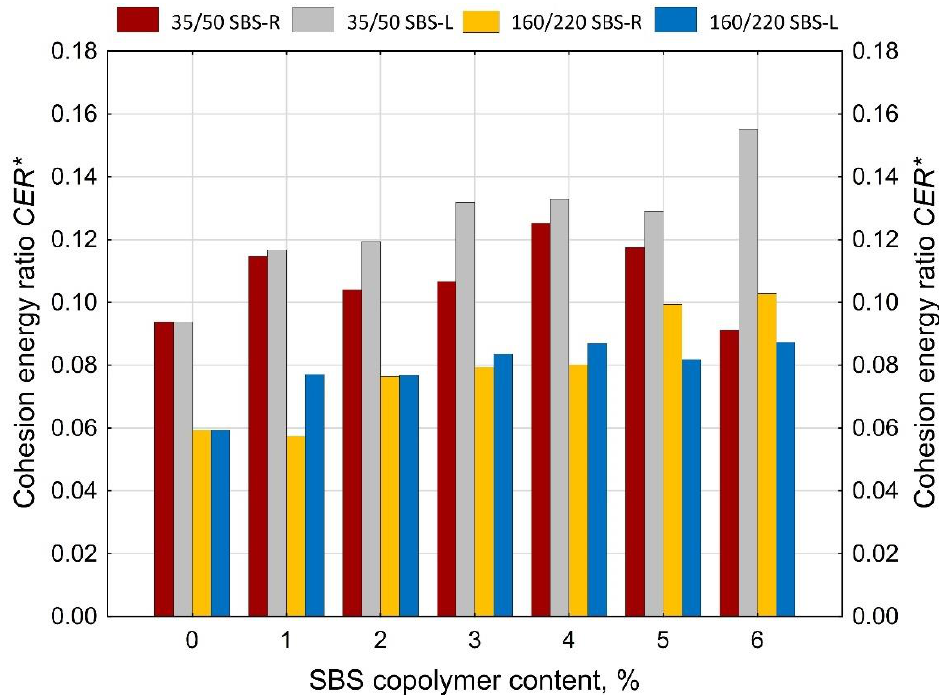
Figure 21. Values of CER * done on the samples of polymer-modified bitumens in the force ductility test, calculated using Equation (6).